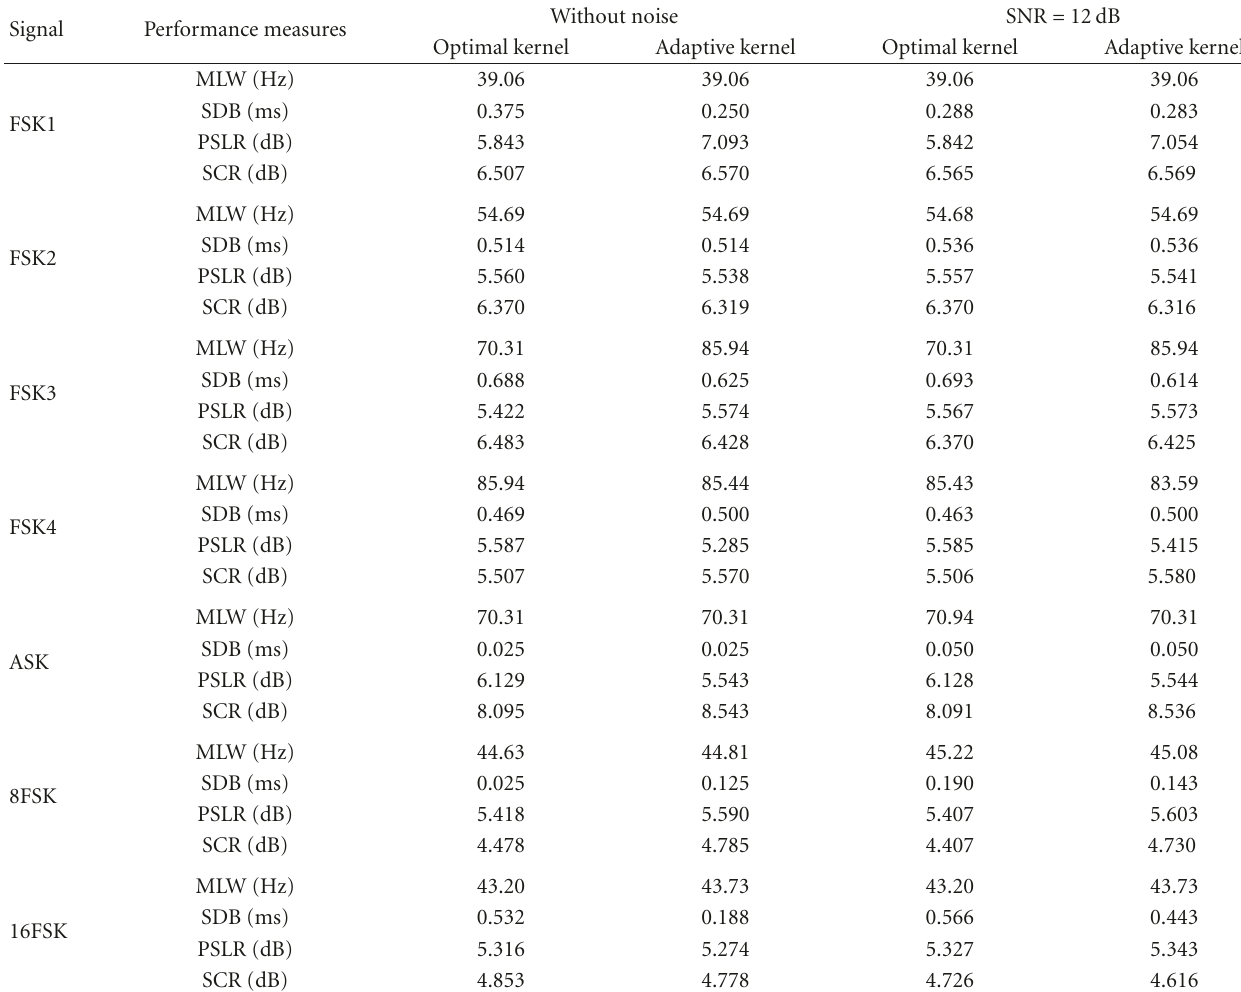
Table 4: Performance comparison between actual kernel and estimated